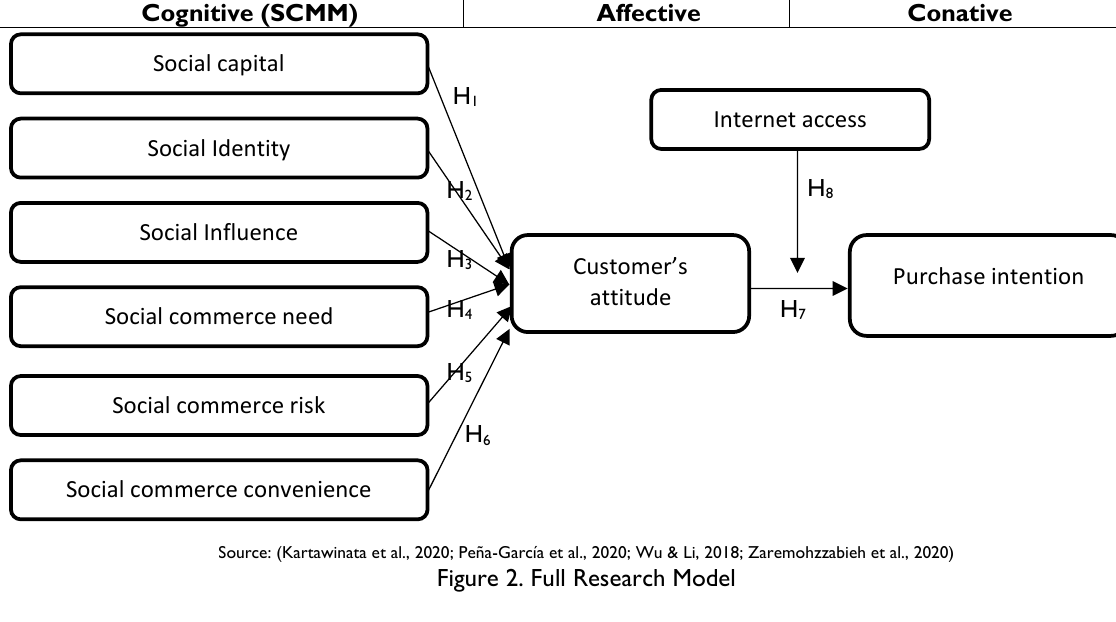
Figure 2. Full Research